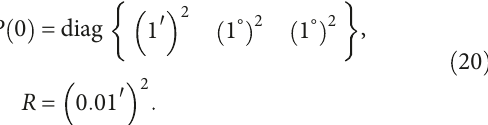
Figure 3: Normalized eigenvalues of the linear distance error between the AUV and the beacon as initial latitude changes.